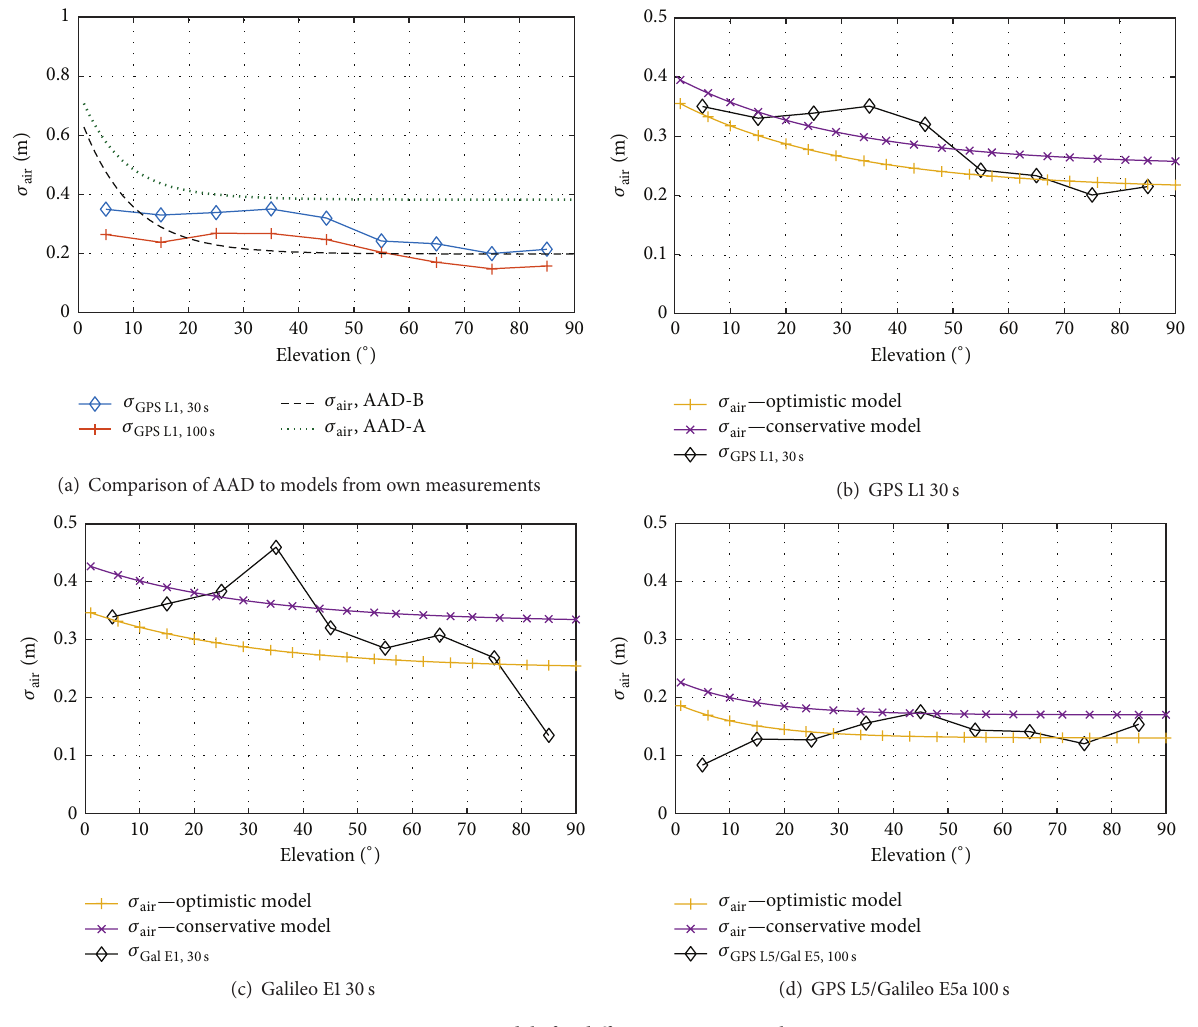
Figure 6: 𝜎 models for different processing air